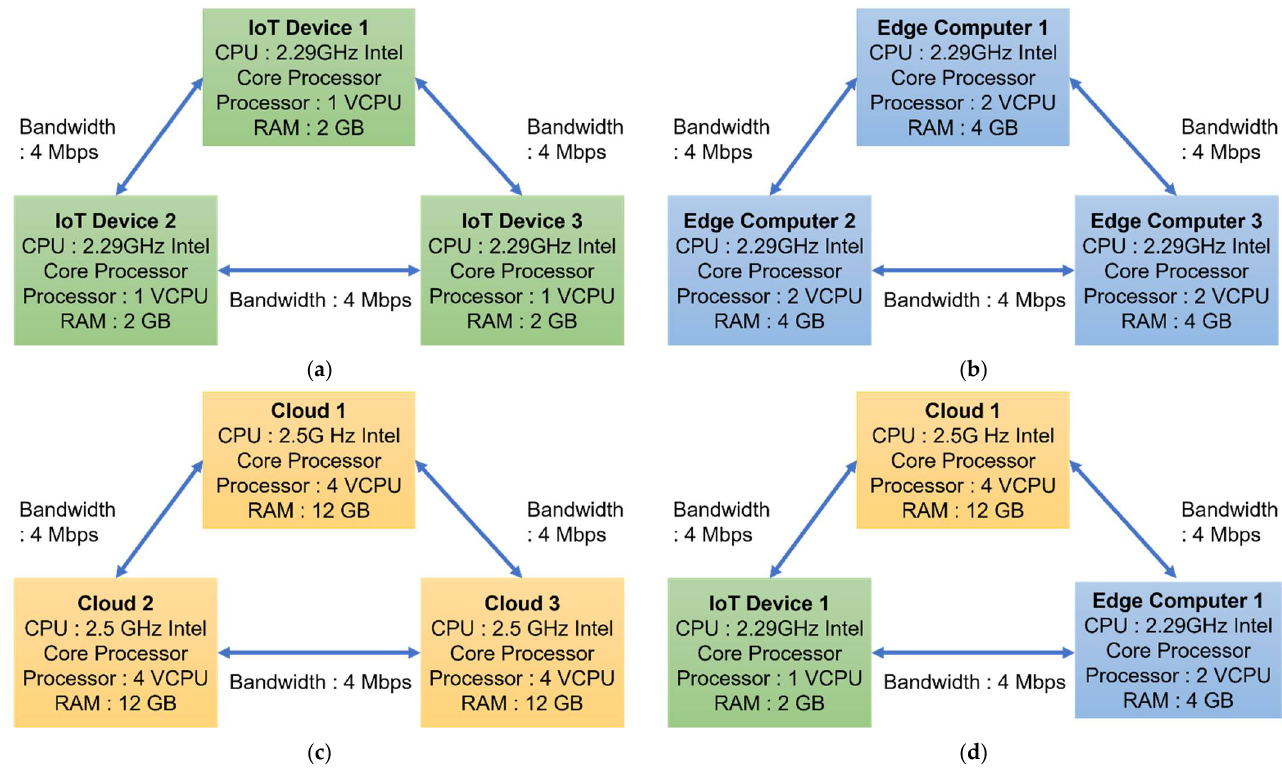
Figure 7. Experimental setup with corresponding system configurations. ( a ) Cluster 1 (IoT devices). ( b ) Cluster 2 (edge computers). ( c ) Cluster 3 (cloud servers). ( d ) Cluster 4 (IoT devices, edge computer, and cloud server). Table 3. System configurations of the computing